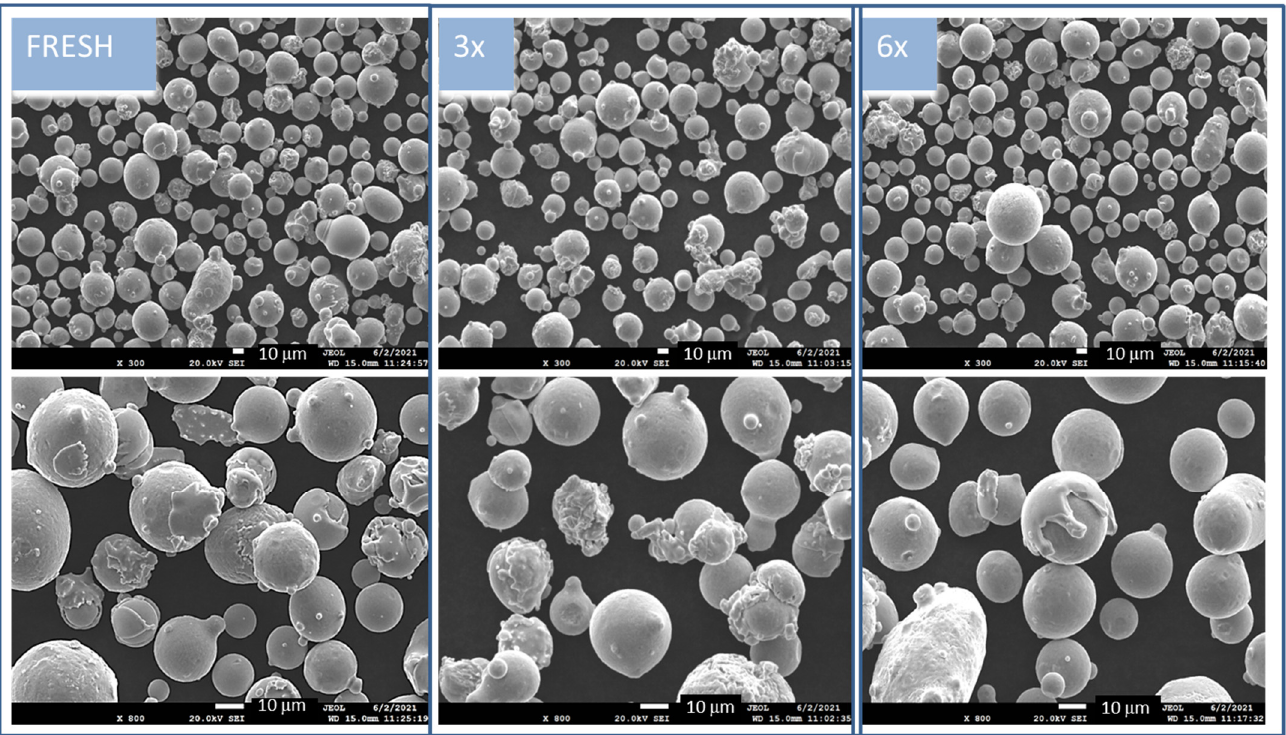
Figure 1. Morphology of all nontreated powders in two magnifications—at 300× in upper row images, and in more detail, focusing on individual particles, at 800× (bottom row images) in the mode of secondary electrons (SE); scale bar indicated in white color is 10 mm.